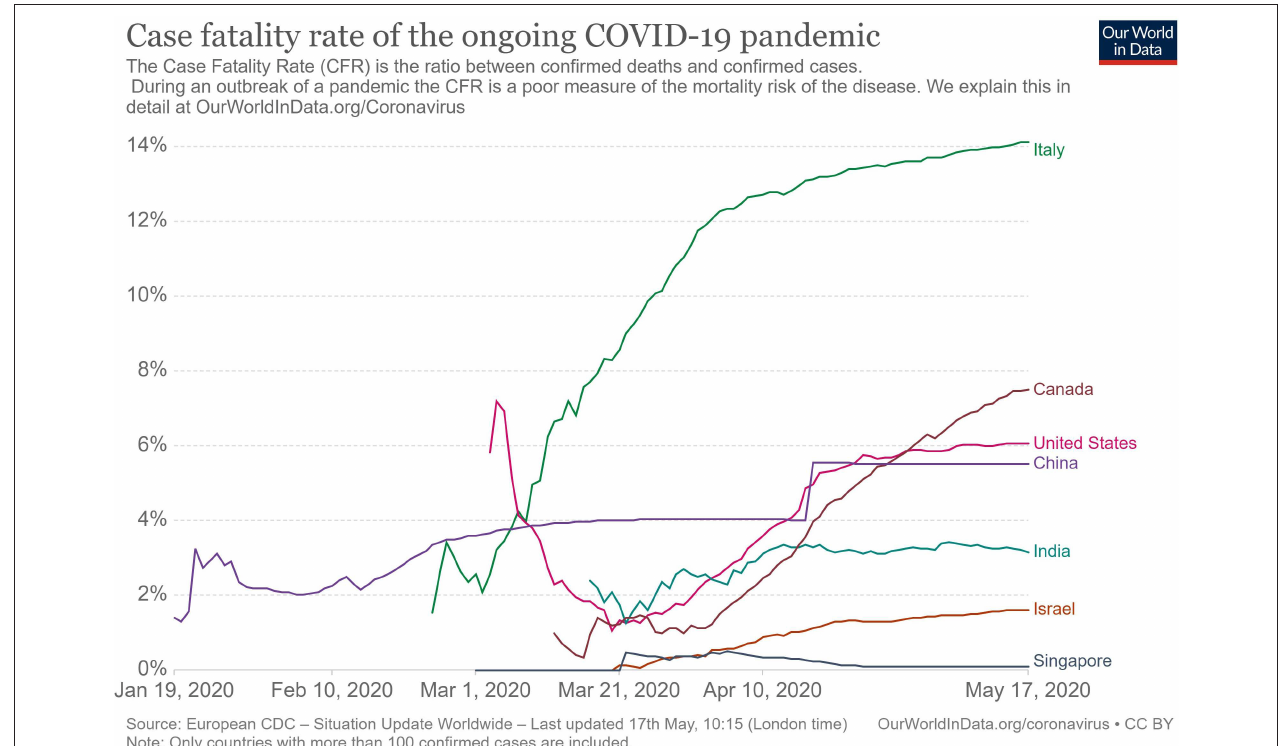
FIGURE 4 | Case fatality rate in selected countries (33).